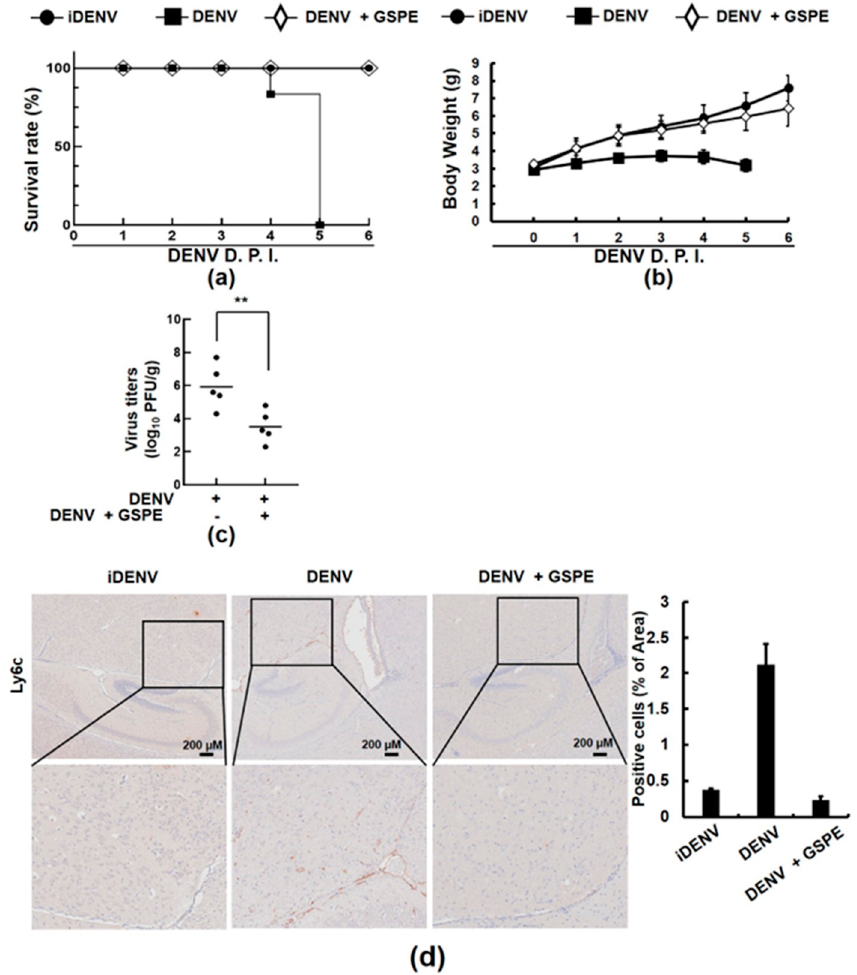
Figure 5. GSPE protects ICR suckling mice from DENV-caused death. Six-day-old ICR suckling mice were intracerebrally injected with 1 × 10 5 PFU of DENV-2 or iDENV. GSPE (20 mg/kg) was intracerebrally administered at 1, 3, and 5 dpi. The survival rates ( a ) and body weights ( b ) of the mice were measured daily after viral infection and GSPE treatment. ( c ) The DENV titer in the brain was determined by plaque assay. Each point was calculated from an average of all animals in the group (n = 5). ** p < 0.01. ( d ) Monocyte infiltration was examined by IHC staining using an anti-Ly6C antibody and further quantified with ImageJ software from at least five random images of each group, each of which contained five mice. The results were collected and plotted daily until the mice died or were sacri fi ced at day 6 dpi by CO 2 asphyxiation.